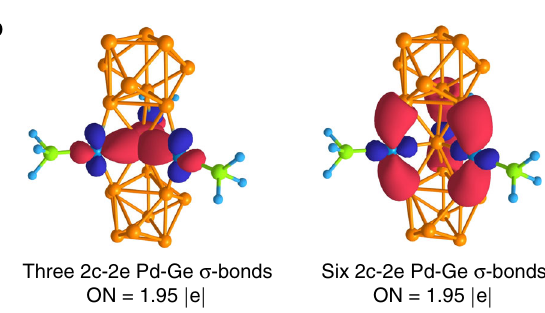
Eighteen 5c-2e bonds (Three per cap, only two sets are shown) ON = 1.94–1.84 ⎪ e ⎪